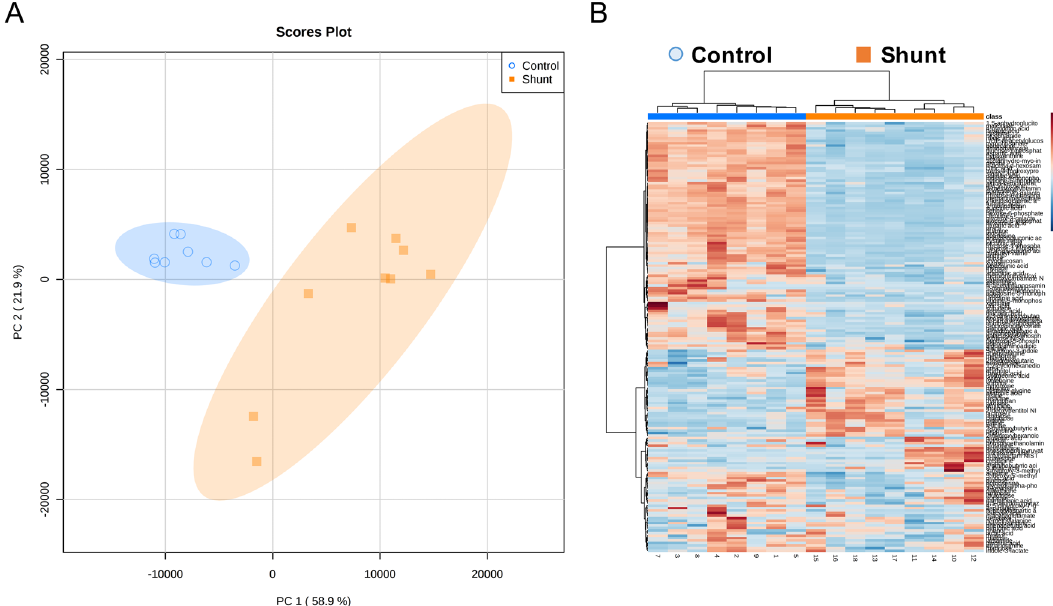
Figure 6. Untargeted metabolomic analysis of cultured LECs isolated from control and shunt lambs, N = 3 control, 3 shunt. ( A ) Principal component analysis and ( B ) heat map of metabolites identified by tandem gas chromatography–mass spectrometry identify differential cellular metabolite concentrations.